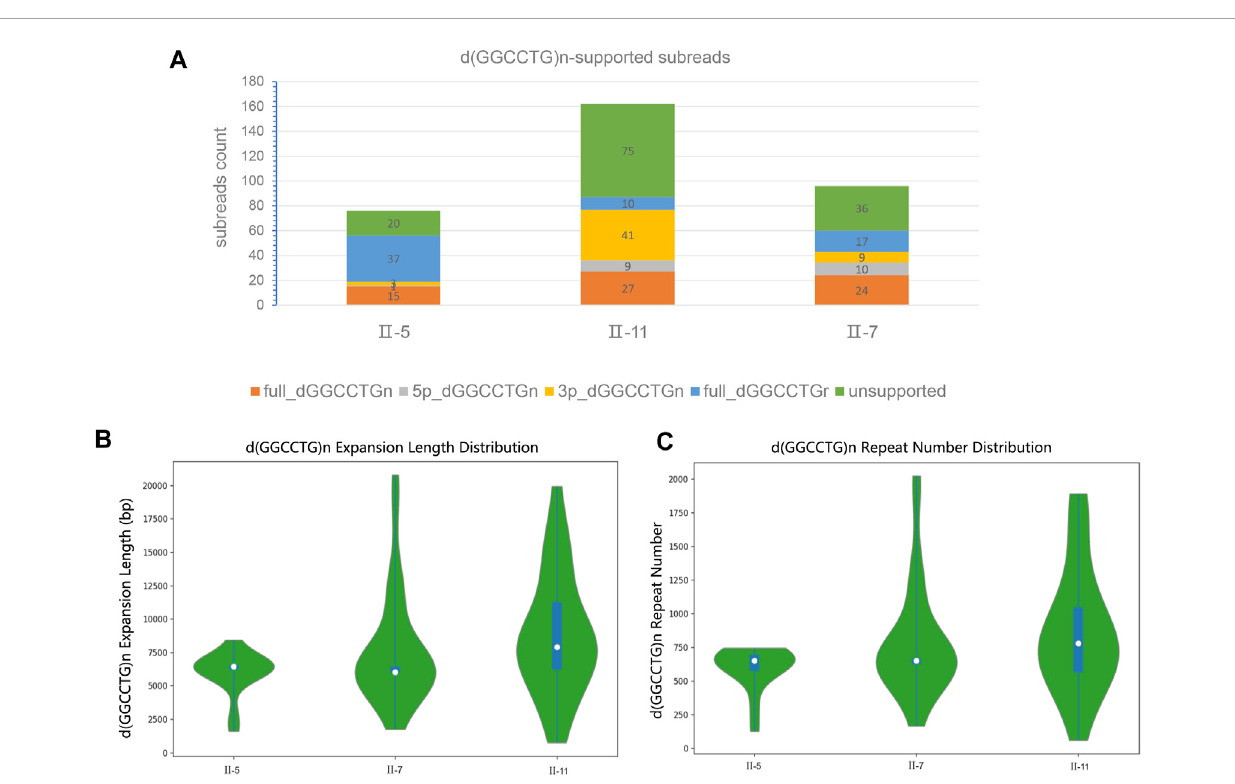
FIGURE 3 The classi fi cation and statistics of the subreads based on SMRT sequencing. (A) The numbers of classi fi cation d (GGCCTG) n-supported subreads. (B) The full_dGGCCTGn subreads of length distribution in three patients. (C) The full_dGGCCTGn subreads of repeat number distribution in three patients. These data suggests the existence of somatic heterogeneity in SCA36